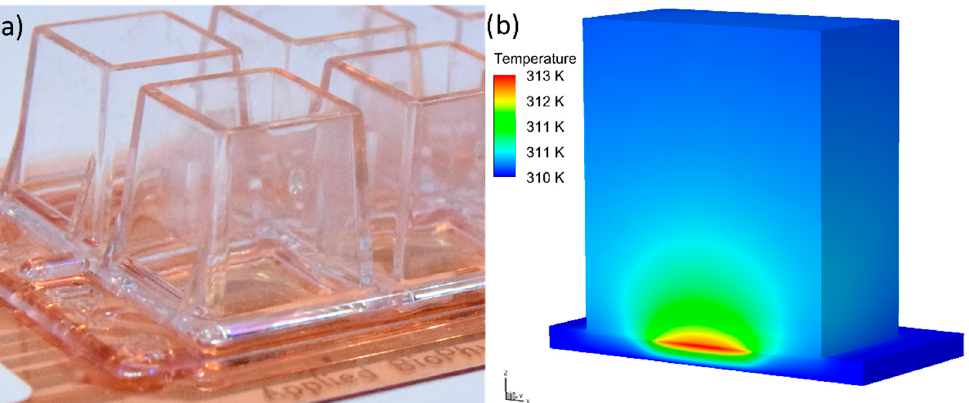
Figure 6. Culture well with the heater active area marked ( a ) and simulation results of the temperature distribution in the cross-section of the well with capacitor electrodes for the power dissipated from the microheater of 22.6 mW in a steady state ( b ).